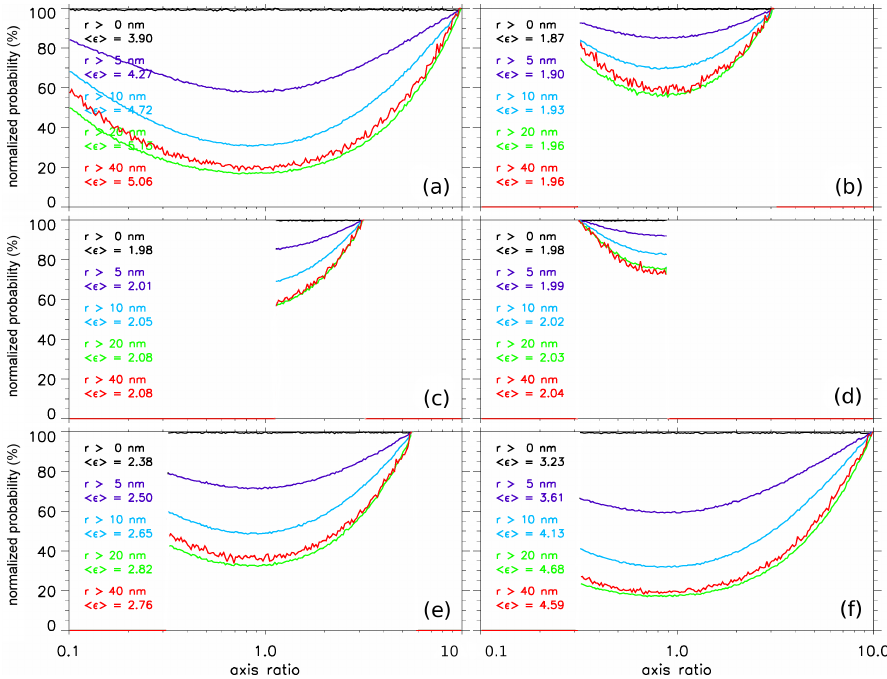
Figure 9. Shape distribution of simulations with non-spherical particles on 16 July 2009 at 24:00UT; panels (a) to (f) are arranged analogous to Fig. 6. Black lines are the initial (log ε ) uniform distributions including all ice particles; colored lines show shape distributions for particles larger than a given threshold. For each radius threshold the distributions are individually normalized to the most common particle shape, and mean ε values ( (cid:104) ε (cid:105) ) are calculated using 1 for ε < 1. ε